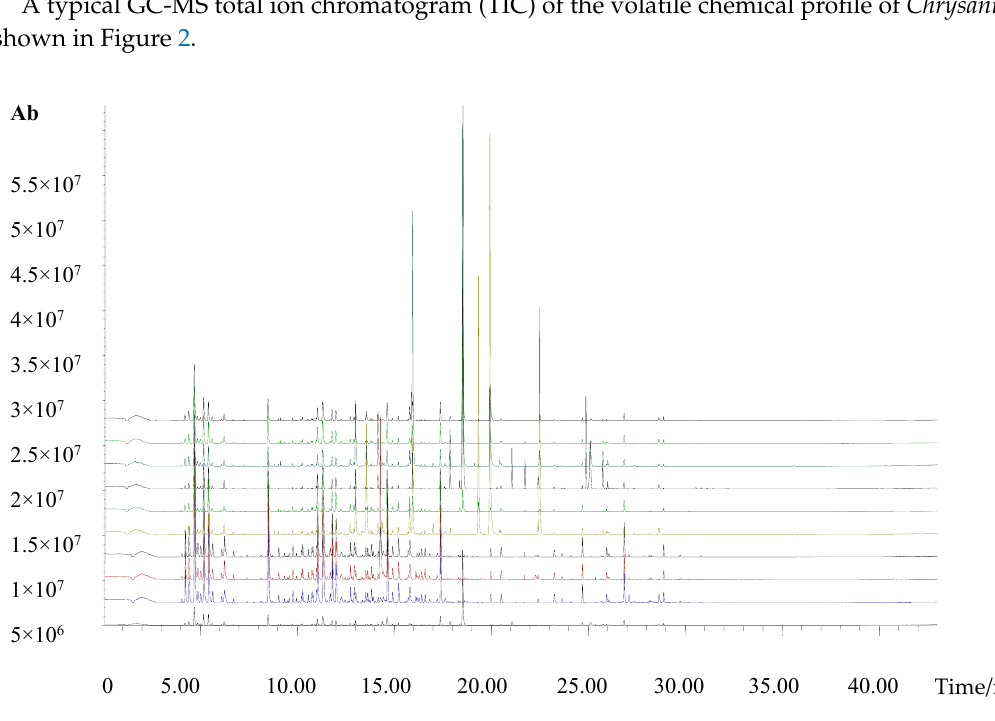
Table 1. Antioxidant activity values for Chrysanthemum morifolium.